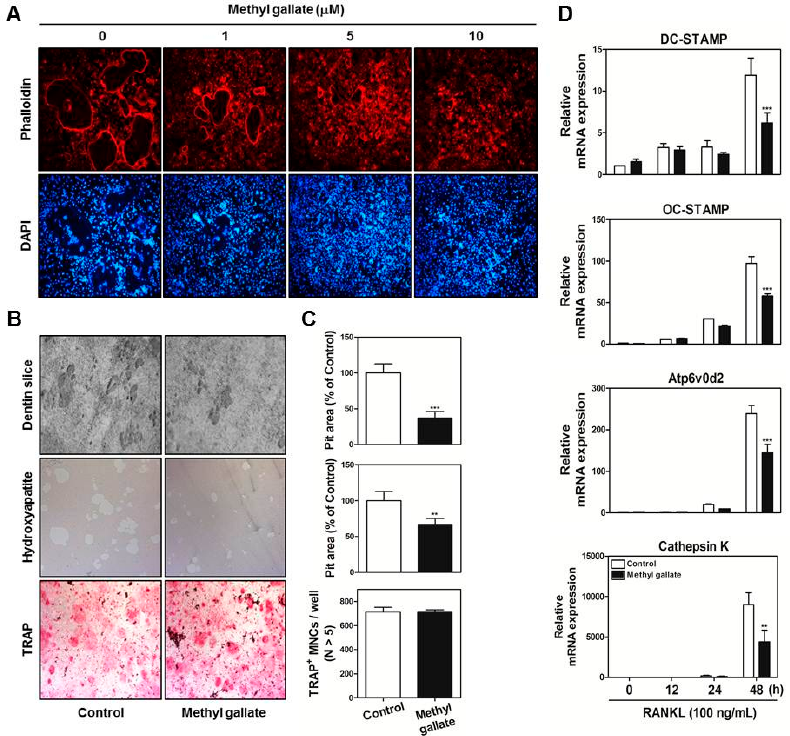
Figure 3. Methyl gallate attenuates F-actin ring formation and bone-resorbing activity of mature osteoclasts. ( A ) BMMs were cultured with M-CSF (30 ng/mL) and RANKL (100 ng/mL) in the presence of the indicated concentrations of methyl gallate. The cells were fixed, permeabilized, and stained with phalloidin and 4 ′ ,6-diamidino-2-phenylindole (DAPI). The cells were examined under a confocal laser scanning microscope at the indicated magnification (10×); ( B ) Mature osteoclasts from the coculture system were seeded in 48-well plates with incubation for 6 h, in hydroxyapatite-coated plates with incubation for 24 h, or on dentin slices with incubation for 48 h with or without methyl gallate (10 µM). After that, cells attached to 48-well plates were stained with a TRAP solution, and the cells on hydroxyapatite-coated plates or dentin slices were removed and photographed under a light microscope at the indicated magnification (10×); ( C ) Pit areas on hydroxyapatite-coated plates or dentin slices were quantified using the Image Pro-PLUS (ver. 4.5) software, and the number of TRAP-positive NMCs (nuclei > 5) was determined. *** p < 0.001 vs. control group; ( D ) The mRNA expression levels of DC-, OC-STAMP, Atp6v0d2, and Cathepsin K were analyzed by quantitative real-time RT- PCR. ** p < 0.01; *** p < 0.001 vs. control group at the corresponding time point.